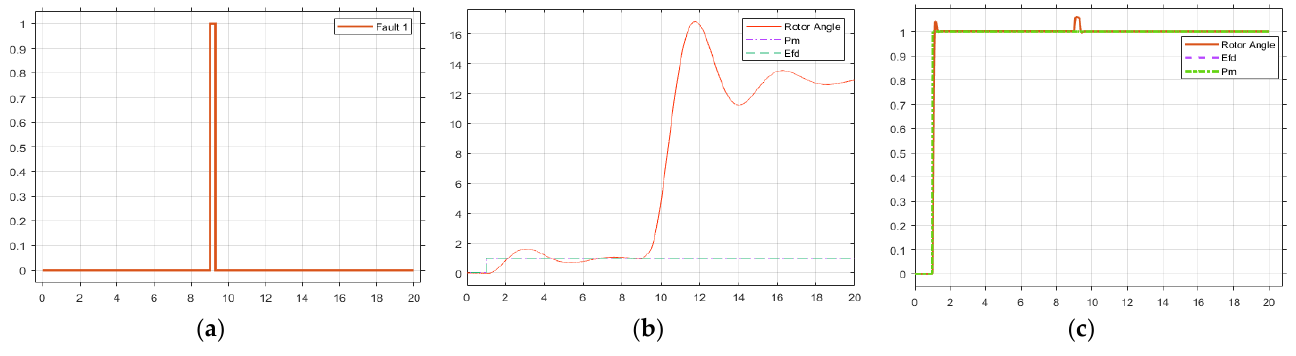
Figure 7. Rotor angle’s response when E FD = 1, P m = 1, and a 300ms fault at t = 9 s. ( a ) Fault characteristics; ( b ) the Lyapunov-based trajectory tracking controller is applied to the system; ( c ) the MRAC is applied to the system.